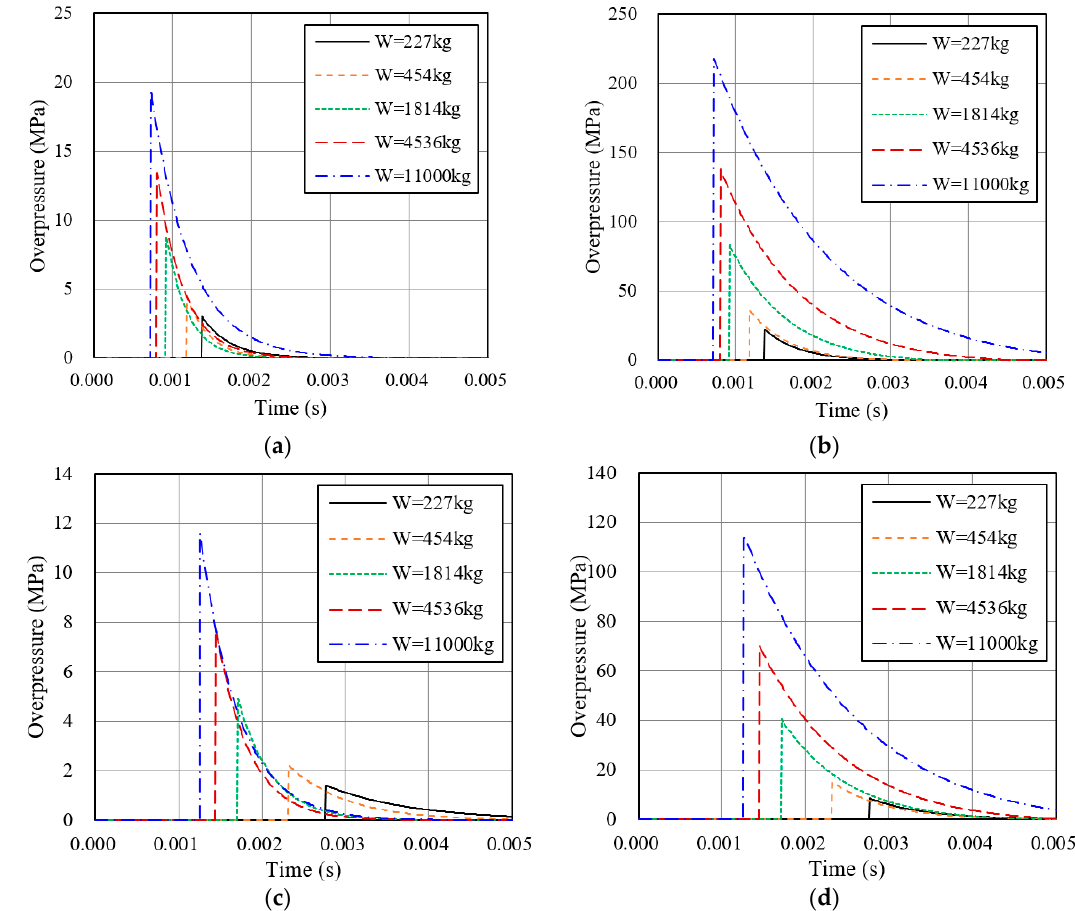
Figure 5. Incident, P s , and normally reflected, P r , histories for beam and column. ( a ) Column, P s ; ( b ) Column, P r ; ( c ) Beam, P s ; ( d ) Beam, P r .